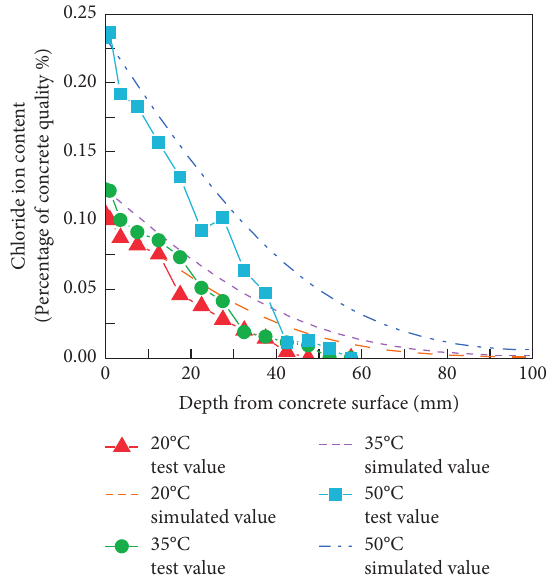
Figure 9: Chloride content distribution in concrete at 20 ° C, 35 ° C, and 50 °